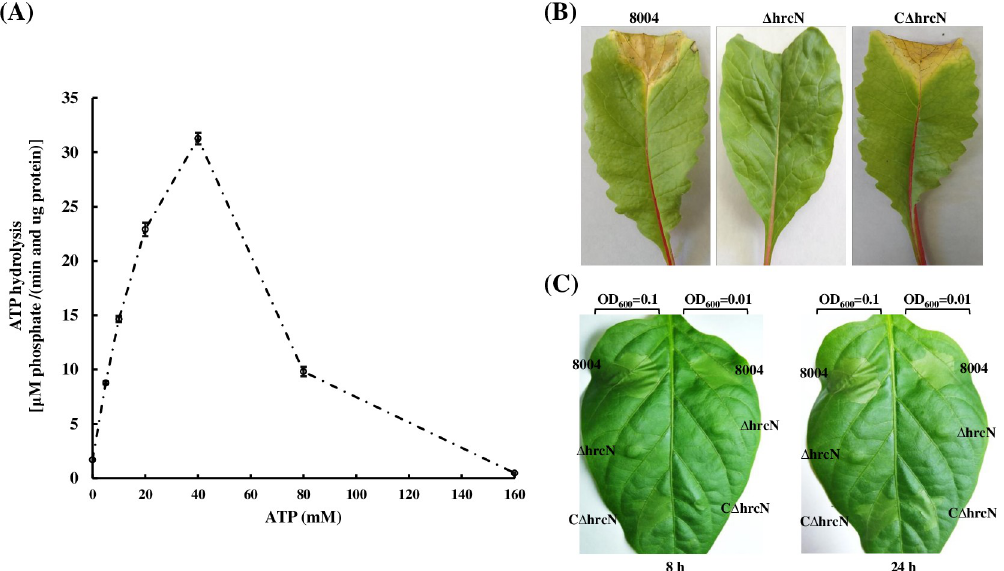
Fig 7. HrcN, a T3SS-associated ATPase, is required for virulence and HR of Xcc . ( A ) HrcN of Xcc exhibits ATP hydrolysis ability. ATP hydrolysis by 1 μ g purified 6 × His-HrcN was measured using a malachite green phosphatase assay in different concentrations of ATP. Values are the mean ± standard deviation from three repeats. ( B ) The lesion lengths of Chinese radish ( Raphanus sativus var. radiculus cv. Manshenhong) leaves caused by Xcc strains (wild type strain 8004, hrcN deletion mutant Δ hrcN, and complementation of Δ hrcN C Δ hrcN) 10 days post-inoculation. Xcc strains were diluted into 10 ml NYG medium at an OD 600 of 0.001 and inoculated on Chinese radish by cutting-leaf method. ( C ) Xcc strains were inoculated into the leaves of pepper plant ( Capsicum annuum cv. ECW-10R). Leaves were photographed at 8 h and 24 h post-inoculation